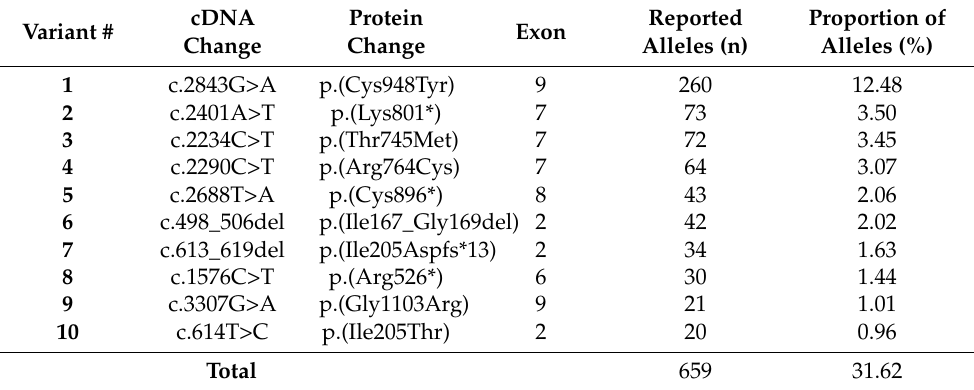
Table 2. The 10 Most Frequent CRB1 Variants in the Leiden Open Variation